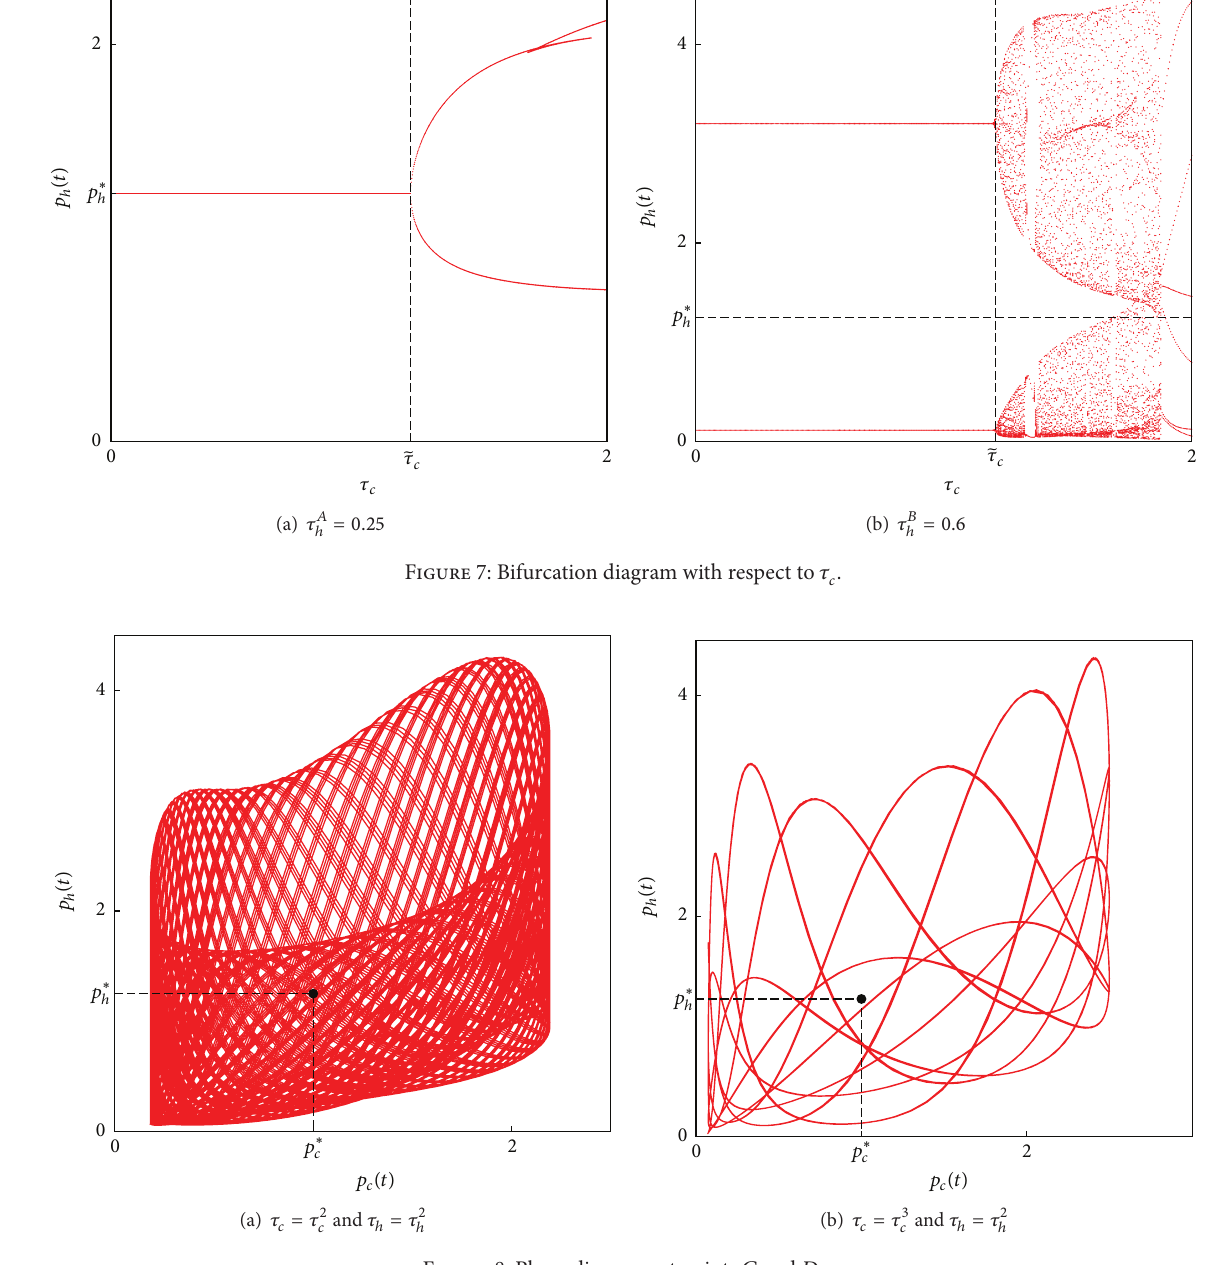
Figure 8: Phase diagrams at points 𝐶 and 𝐷